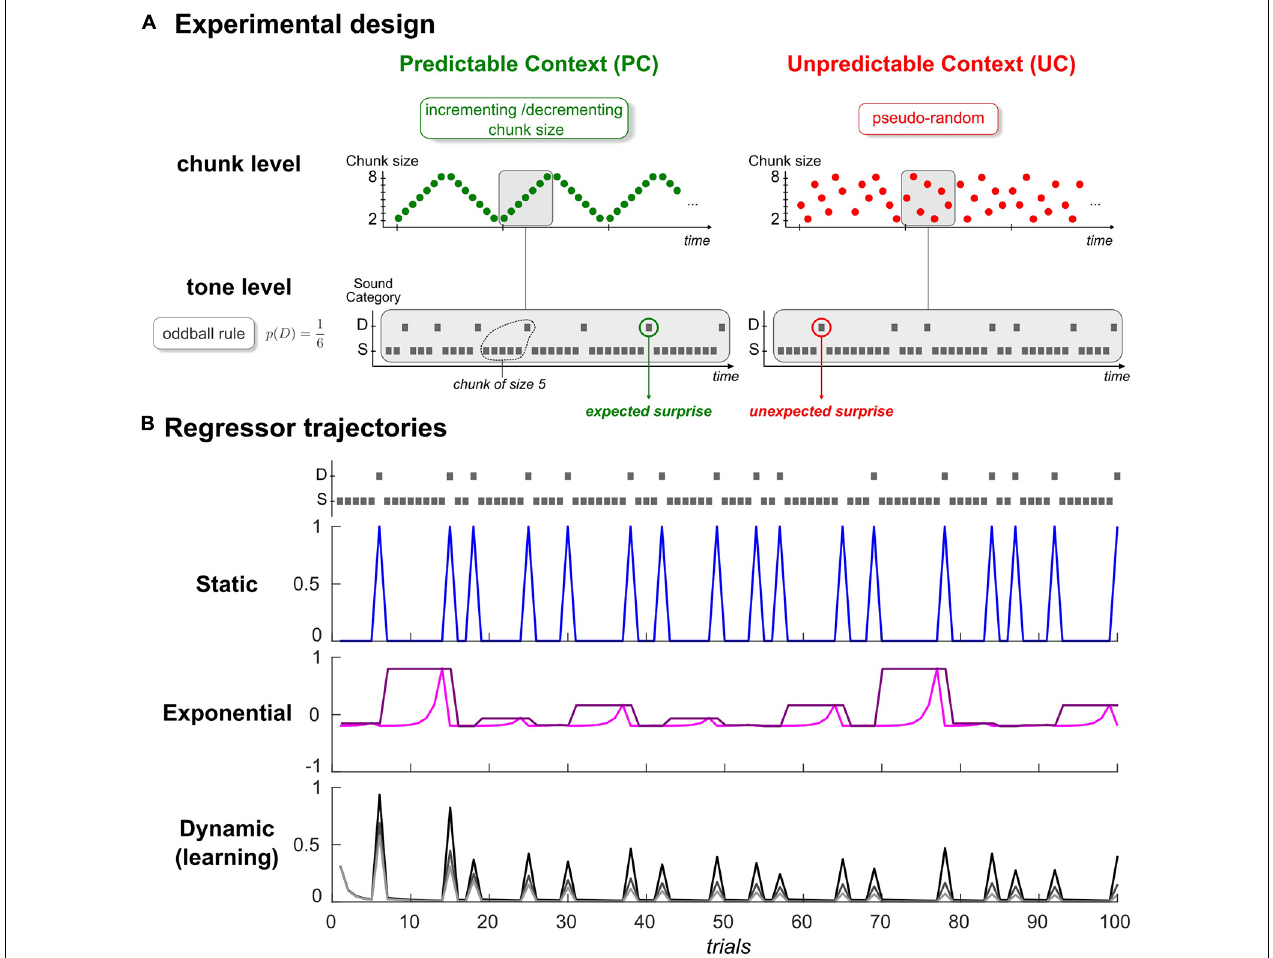
FIGURE 1 | (A) Experimental Design. Schematic view of the predictability manipulation (chunk level) applying to typical oddball sound sequences (tone level). Predictable context (left, green) involves cycles of ordered transitions between segments of repeating standards (chunks), which become shuffled in the Unpredictable context (right, red). Average deviant probability remains the same in both contexts ( p = 1/6). Gray rectangles delineate an exemplary cycle for both sequences. S: Standard, D: Deviant. (B) Examples of regressors for the static (top), exponential (middle), and dynamic (bottom) categories. Each trajectory was simulated with the first 100 tones of one subject in context UC, depicted in the upper panel following the standard/deviant representation in panel (A) . In the static category, deviant regressor is shown in blue (standard regressor is not displayed for convenience, as it mirrors deviant regressor). Exponential rank and chunk size regressors are presented in pink and purple, respectively. Regarding the learning regressor, three examples of Bayesian Surprise trajectories are provided, and were generated from different time constant values (parameter τ in (Eq. 3); 10,20 and 50: from dark to light